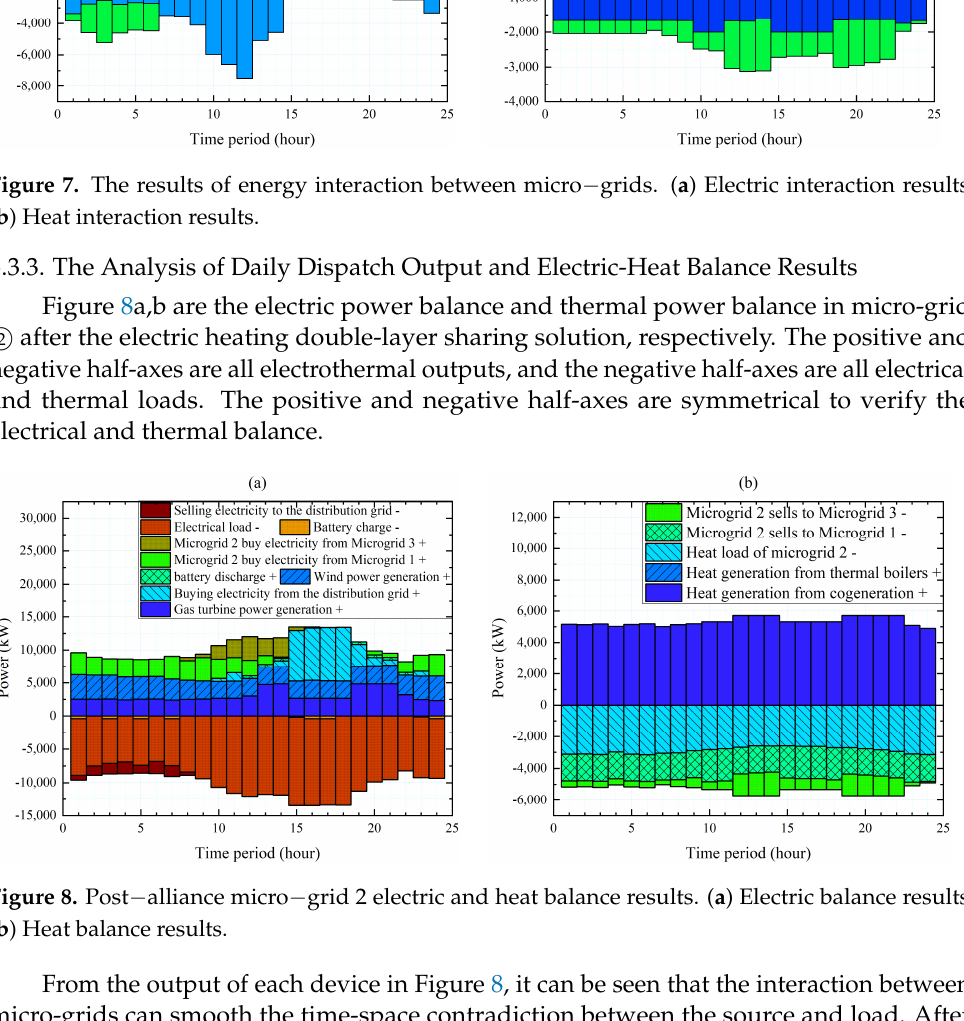
Figure 7. The results of energy interaction between micro−grids. ( a ) Electric interaction results. ( b ) Heat interaction results.